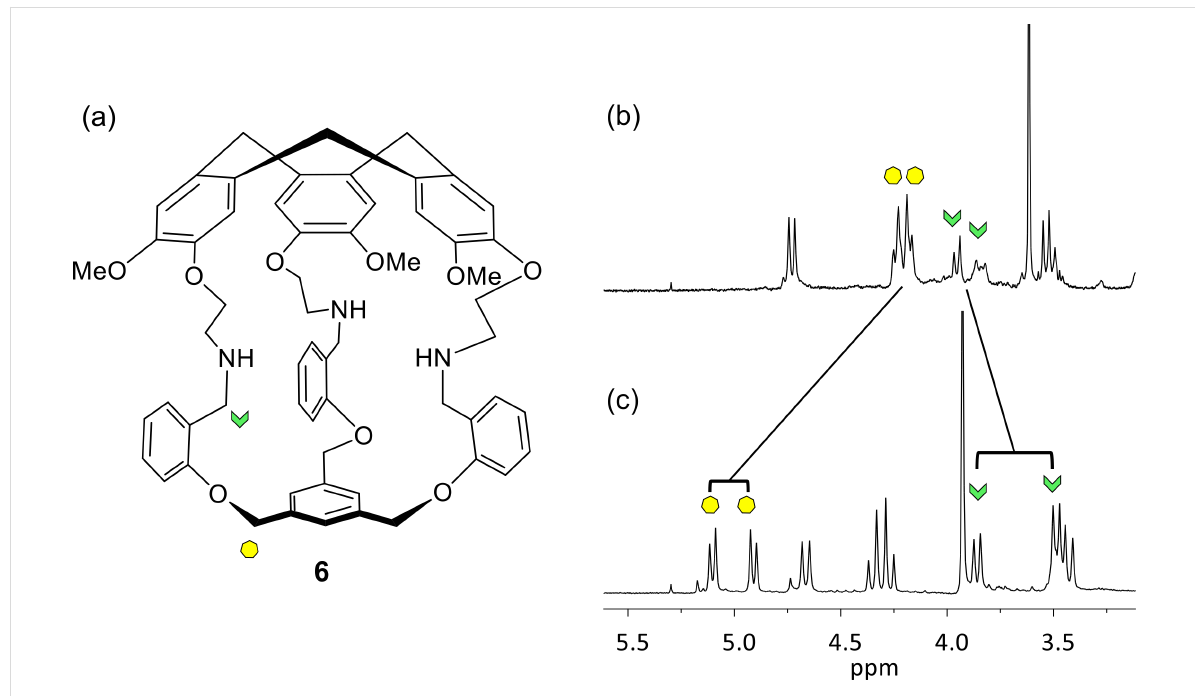
Figure 3: (a) Structure of compound 6 . (b) 1 H NMR of 6 (CDCl 3 , 400 MHz). (c) 1 H NMR of 1 (CDCl 3 , 400 MHz).